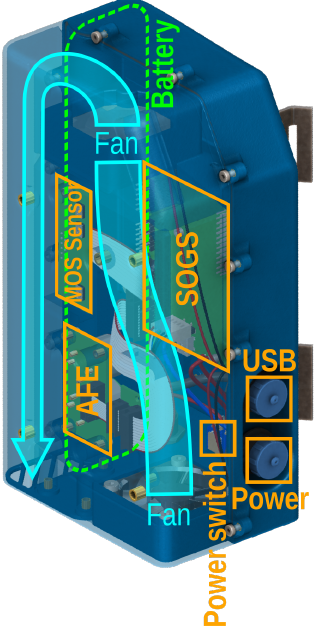
Figure 6. Cutaway of the prototype Zephyr enclosure, showing the layout of vital components and interfaces. Major components are labelled in orange, including an Alphasense AFE electrochemical sensor, which is not the subject of this paper. The MOS instrument boards are suspended away from the casing wall to allow air to flow past both